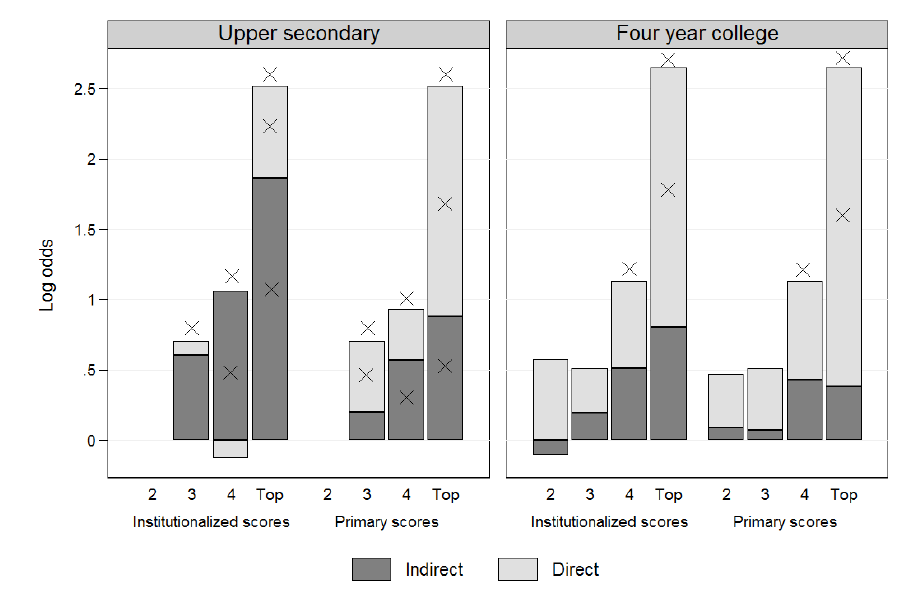
Figure 3: Decomposition of inequalities in transition to upper-secondary academic education and four-year college, log odds ratios, male